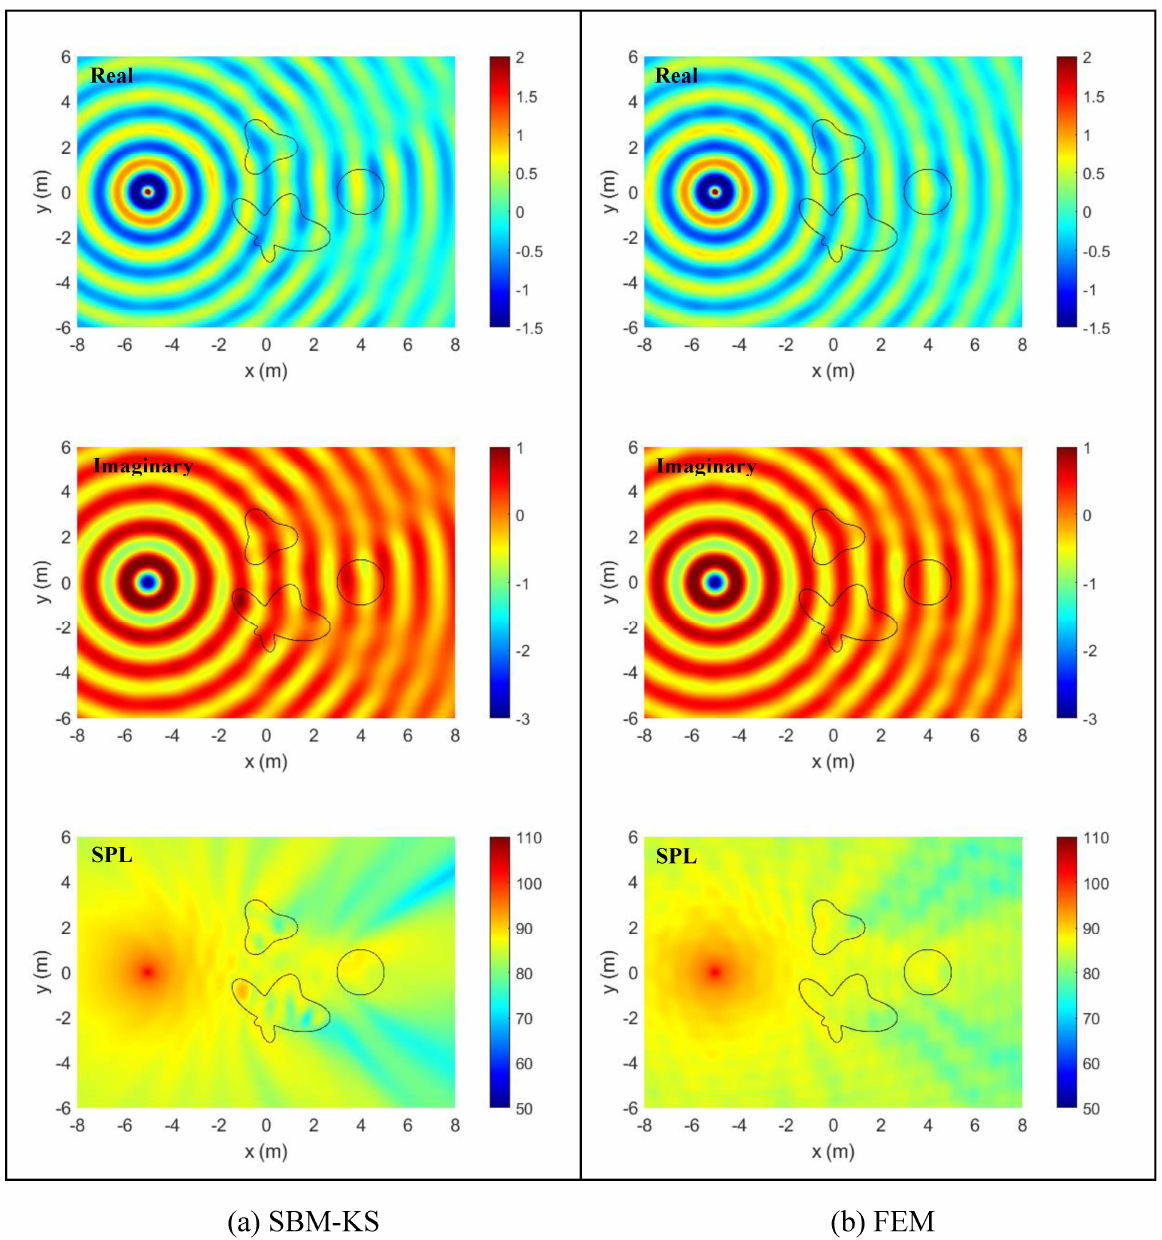
Figure 13. Profiles of sound pressure and sound pressure level obtained using the SBM–KS approach and COMSOL FEM at a frequency of 1000 Hz.